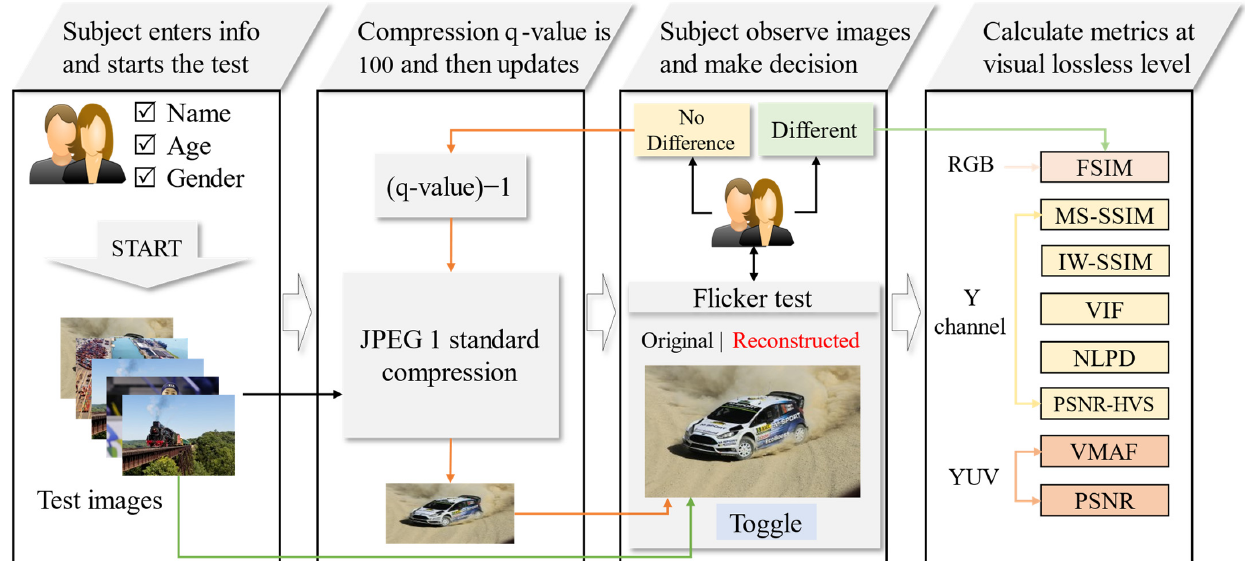
Figure 1. The overall framework of the proposed flicker test for performing subjective assessment and IQMs evaluation at visual lossless compression level. The subject enters his/her information and starts the test. The program selects an image from the test images directory and performs JPEG 1 compression at a quality value (q-value) equal to 100, then displays both the original and reconstructed image in the Unity flicker test, where the subject observes the visual artifacts in the images by toggling the images. When the subject does not observe any flickering, then the image is reconstructed at a lower q-value. In case the subject observes a difference, the IQMs are calculated at the previous q-value (visually lossless stage) and moved to the next image.